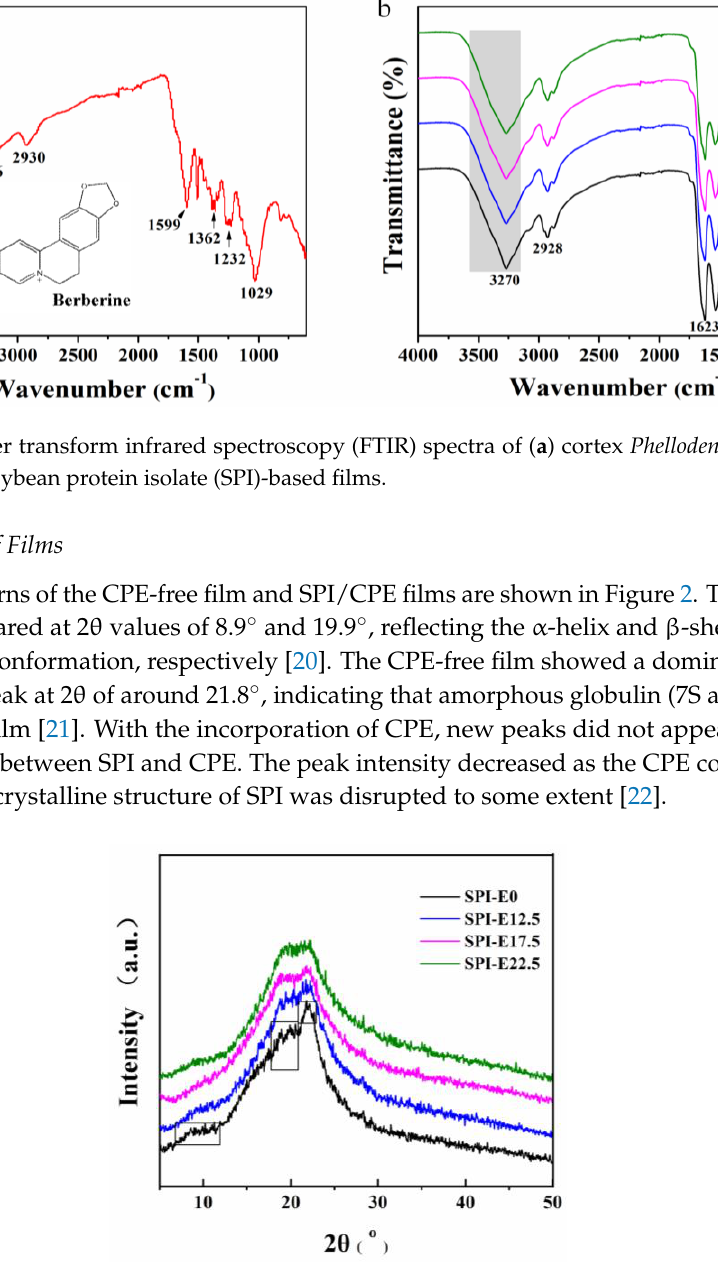
Figure 2. X-ray diffraction (XRD) patterns of the SPI-based films.